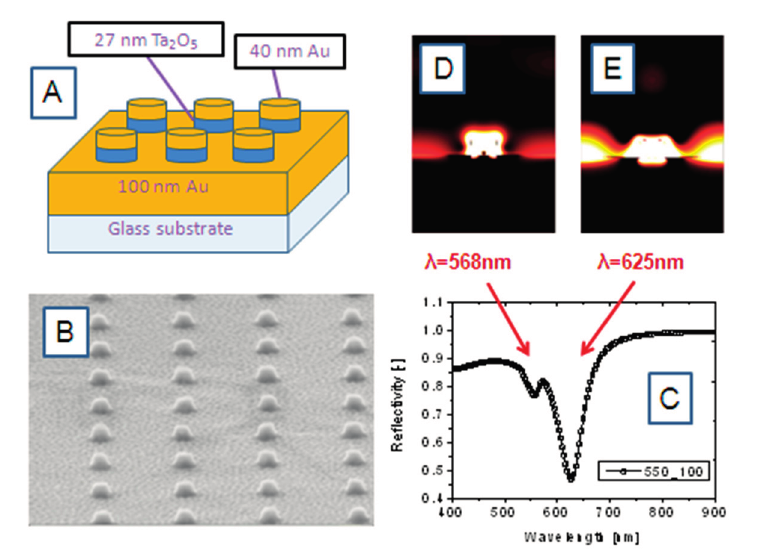
Figure 5. ( A ) Schematic arrangement of the Au nanodisc array for collective excitation of coupled propagating and localized surface plasmon modes; ( B ) SEM image of the nanodisc array; ( C ) reflectivity spectrum of a nanodisc array with a disc diameter of d = 100 nm, and a disc-disc separation distance of s = 550 nm. The (simulated) spatial distribution of the optical intensity associated with the two resonance modes at λ = 568 nm and λ = 625 nm, seen in the reflectivity spectrum are given in ( D ) ( λ = 568 nm) and ( E ) ( λ = 635 nm),